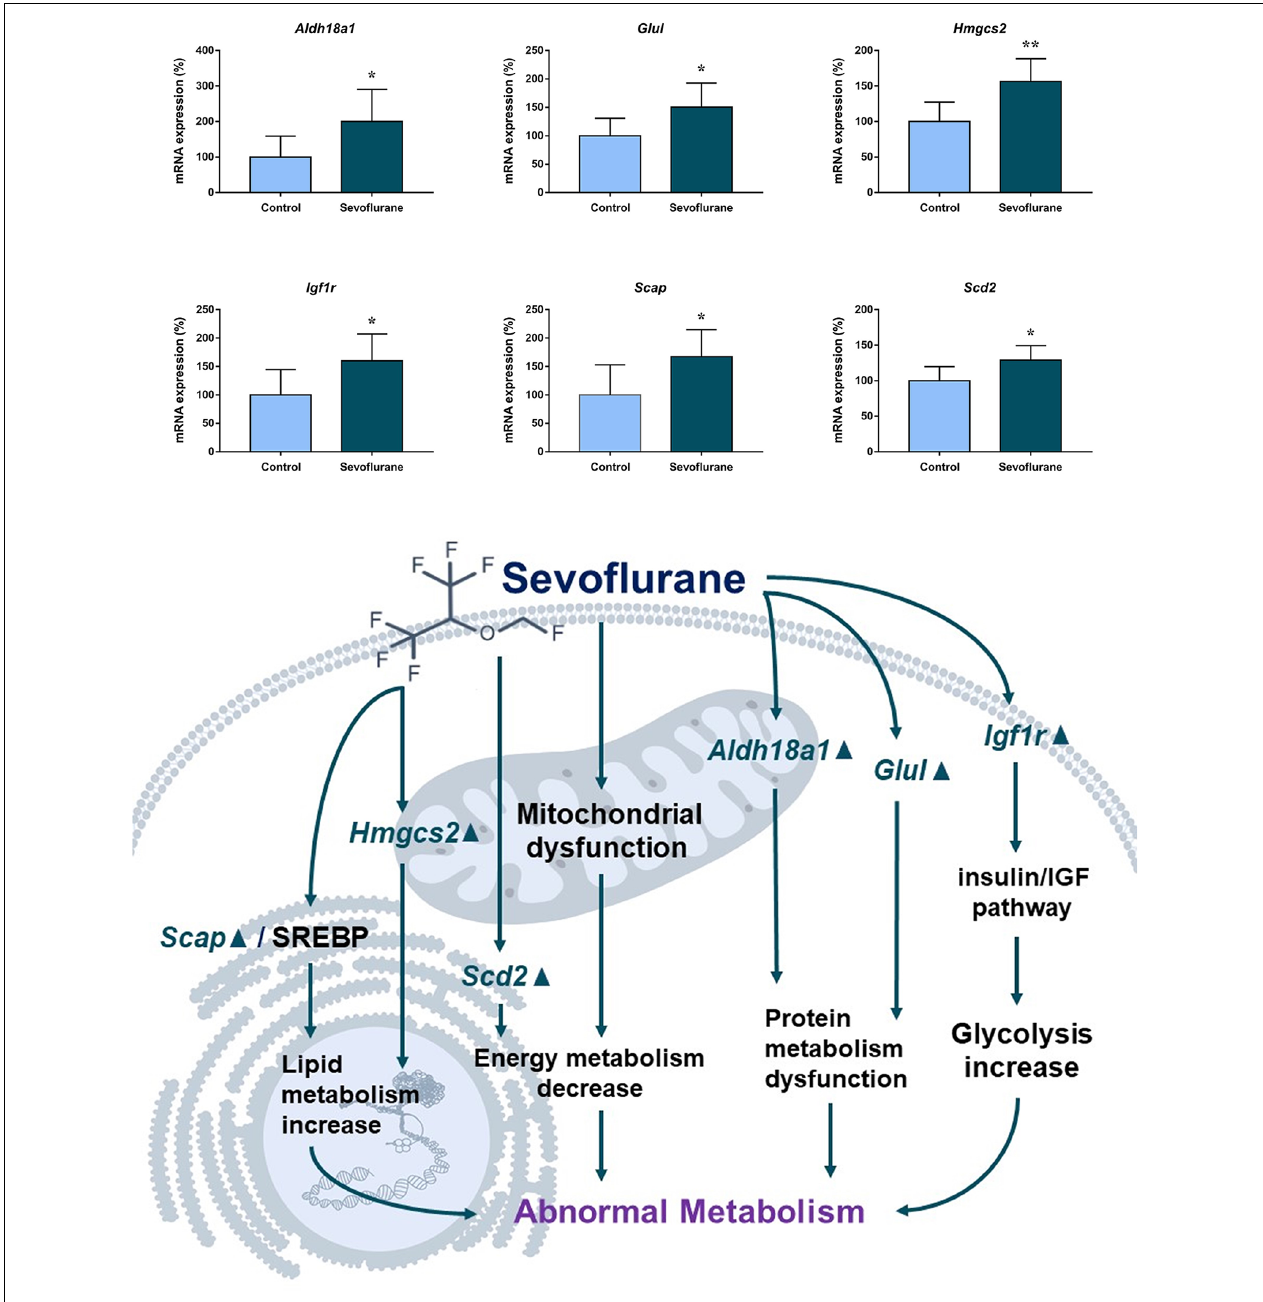
FIGURE 6 | Hypothetical pathway related to metabolism identified with altered DNA expression in the sevoflurane anesthesia group in comparison with the control group. The regular triangle represents genes up-regulated; inverted triangle represents genes down-regulated; Graphs show the difference in expression of Aldh18a1 , Glul , Hmgcs2 , Lgf1r , Scap , and Scd2 were for sevoflurane anesthesia group and controls (* p < 0.05; ** p <